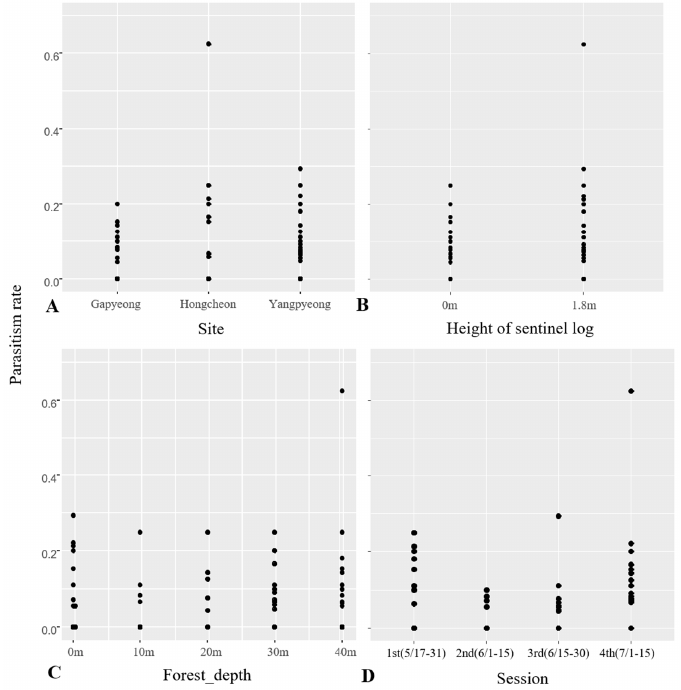
Figure 6. Scatter plot of Spathius verustus in 2017: ( A ) relationship between site and parasitism rate; ( B ) relationship between the height of sentinel log and parasitism rate; ( C ) relationship between forest depth and parasitism rate; ( D ) relationship between session and parasitism rate.